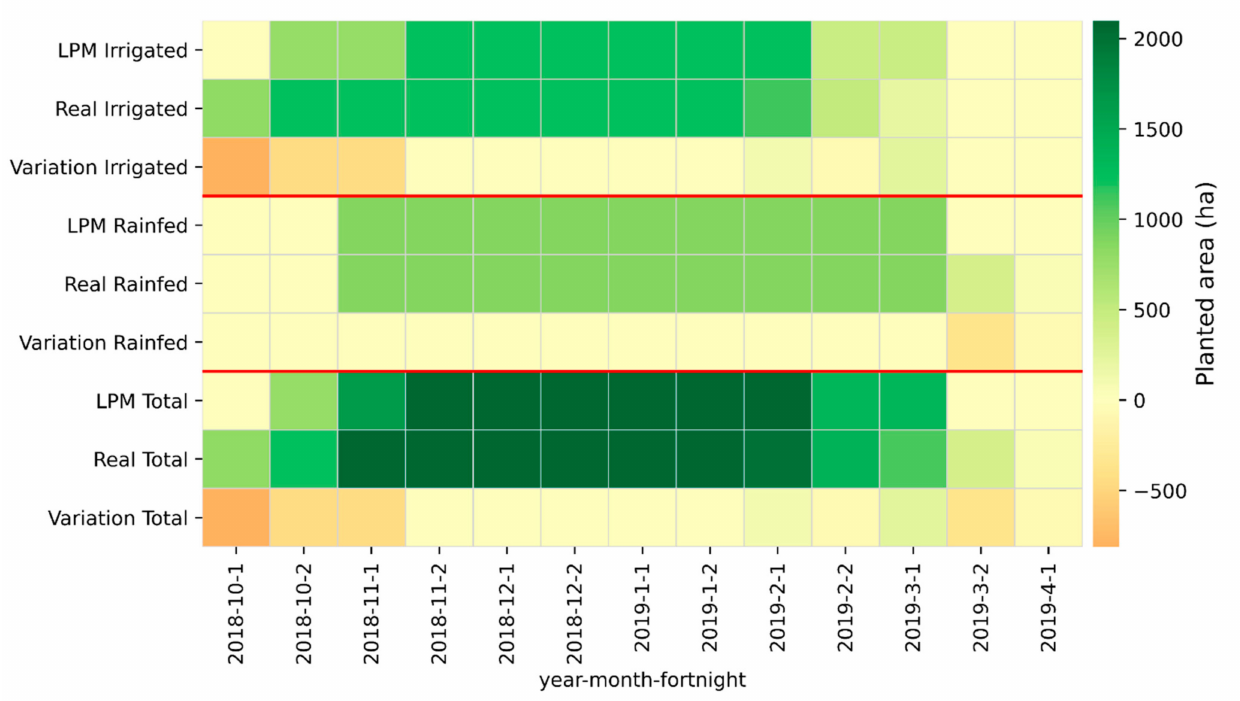
Figure 3. Planted area, in hectares, recommended by LPM application for irrigated and rainfed areas of Sama